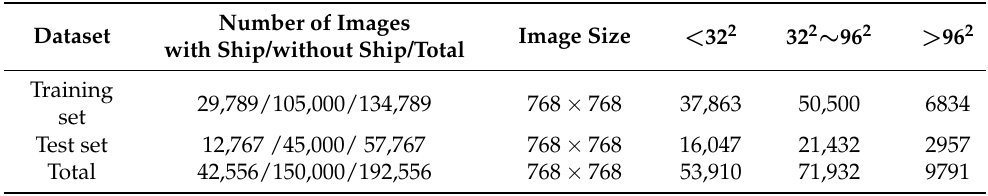
Table 3. Airbus ship detection